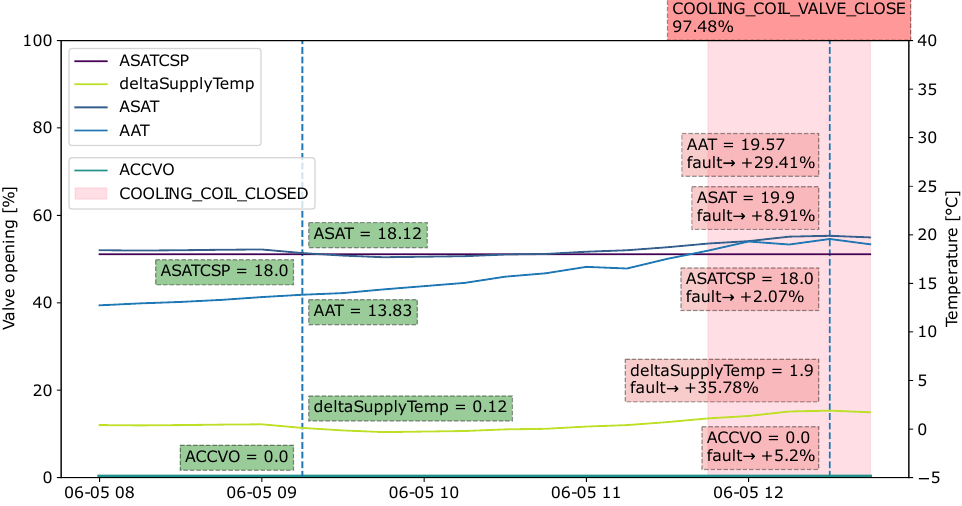
Figure 14. Explanation visualized as a sliding window for the fault type “Cooling coil valve closed” during an observation period from 08:00 to